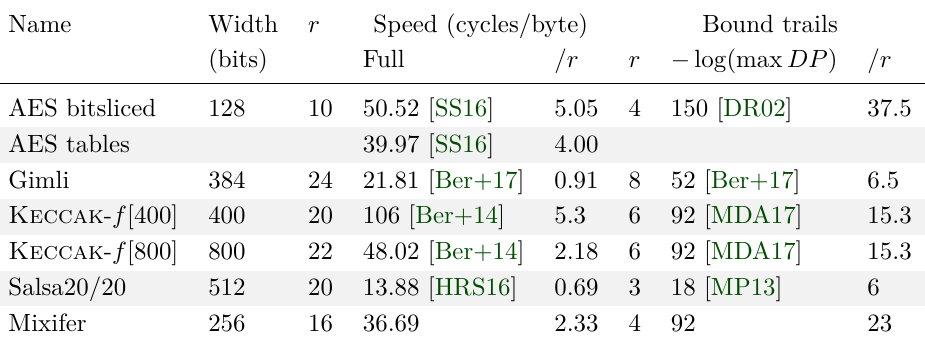
Table 6: Comparison of performance on the Cortex-M3/M4 and